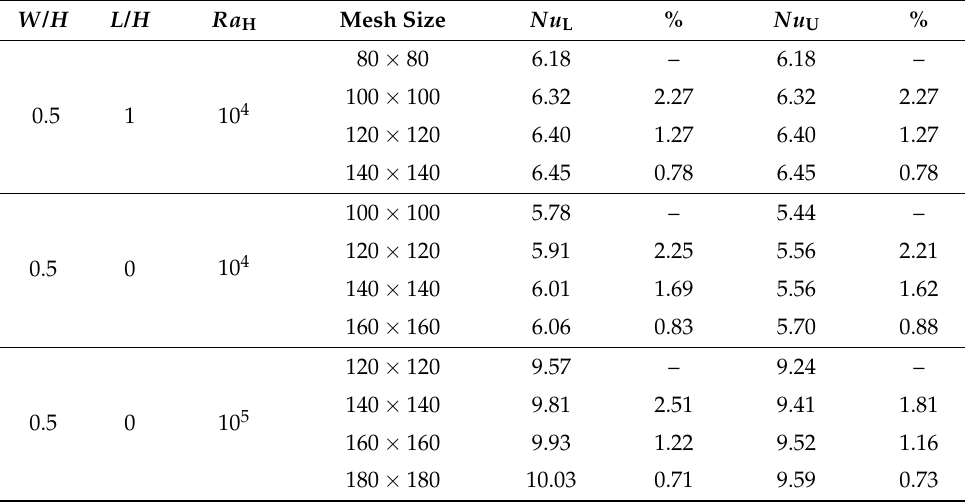
Table 1. Grid sensitivity analysis for W / H = 0.5, L / H = 0 and 1, Ra H = 10 4 and 10 5 . W / H